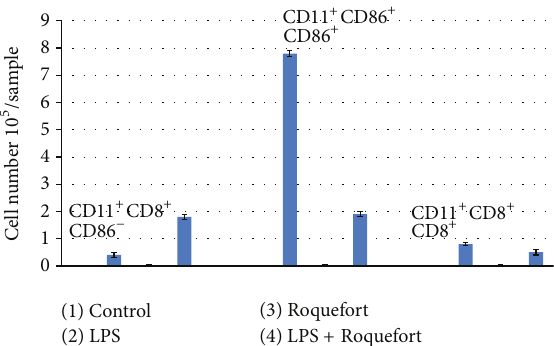
Figure 4: Dendritic cell subpopulations in peritoneal washes obtainedfromLPS-stimulatedmicefedwithRoquefortcheese.Mice were gavaged twice (once daily) with PBS containing 10.0mg of Roquefort cheese or PBS alone (control). 24 hours later, the animals were injected intraperitoneally with LPS or its solvent (PBS). Peri- toneal washes were obtained 48 hours after LPS injection. Dendritic cell subpopulations (CD11 + CD8 + CD86 − , CD11 + CD8 + CD86 + , and CD11 + CD8 + CD + 8 + ) were quantified as described in Section